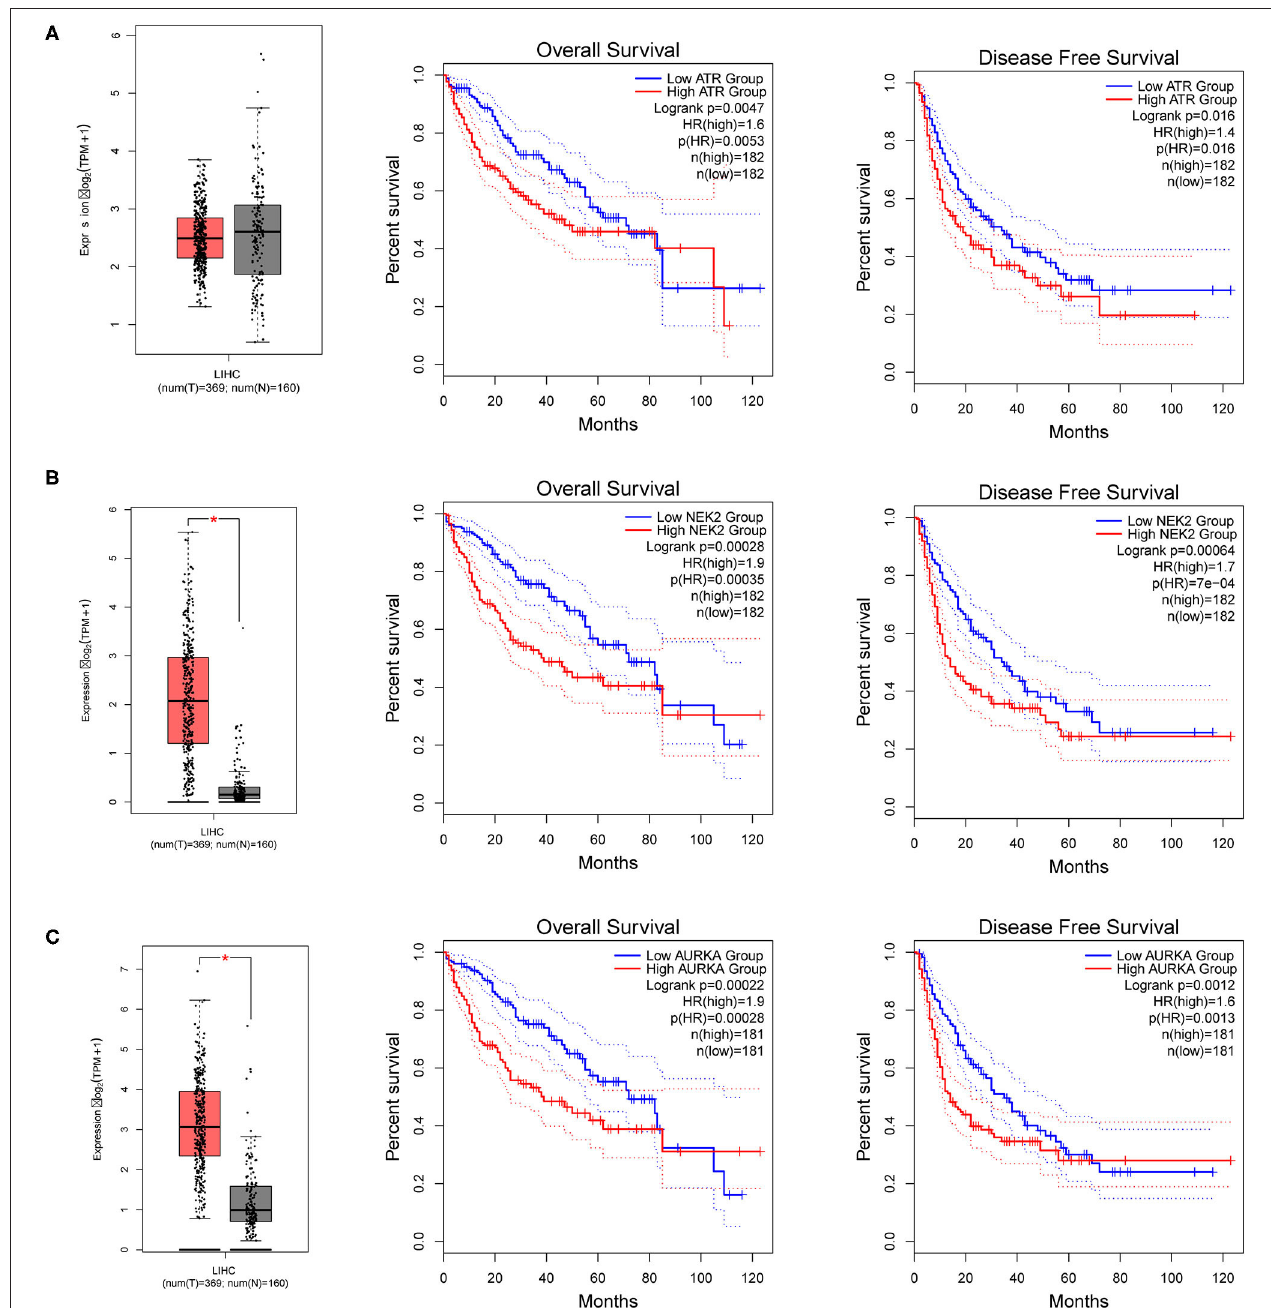
FIGURE 7 | The expression and prognostic significance of NTF3-regulated kinase in HCC. (A) ATR, ATR serine/threonine kinase. (B) NEK2, NIMA-related kinase 2. (C) AURKA, Aurora kinase A.